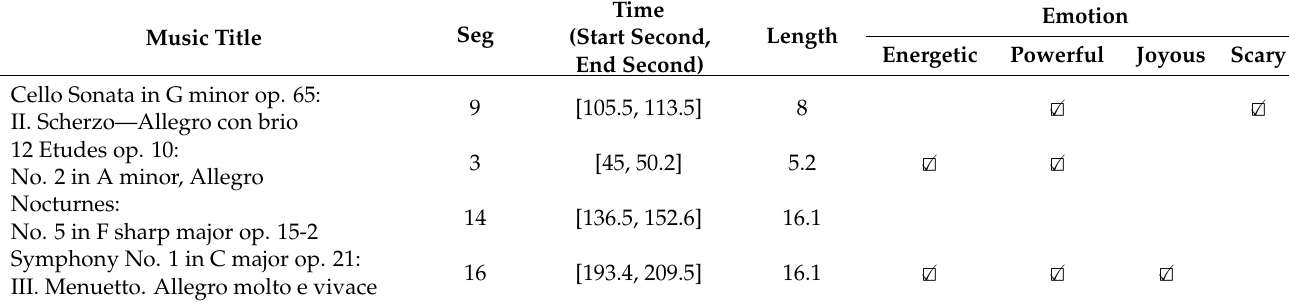
Table 1. Classical Music Segment Data Labelling Result Paper of Classical Music Experts (part).